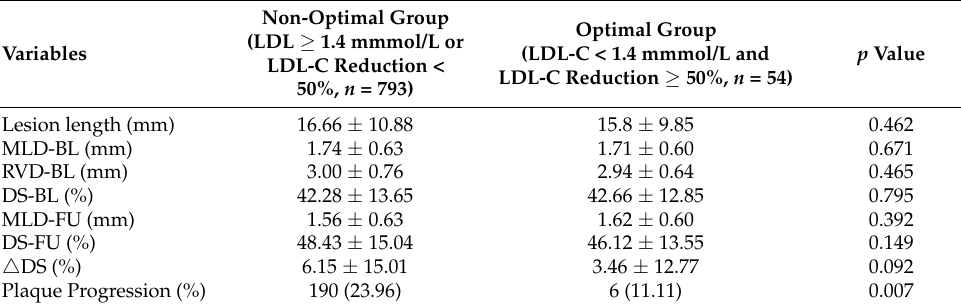
Table 2. QCA analysis of NTLs according to the follow-up LDL-C